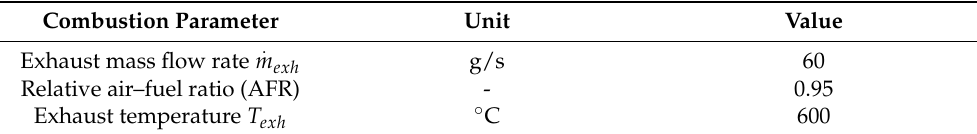
Table 7. Final parameter set for engine-like soot reproduction (soot loading) on the burner test bench. Combustion Parameter